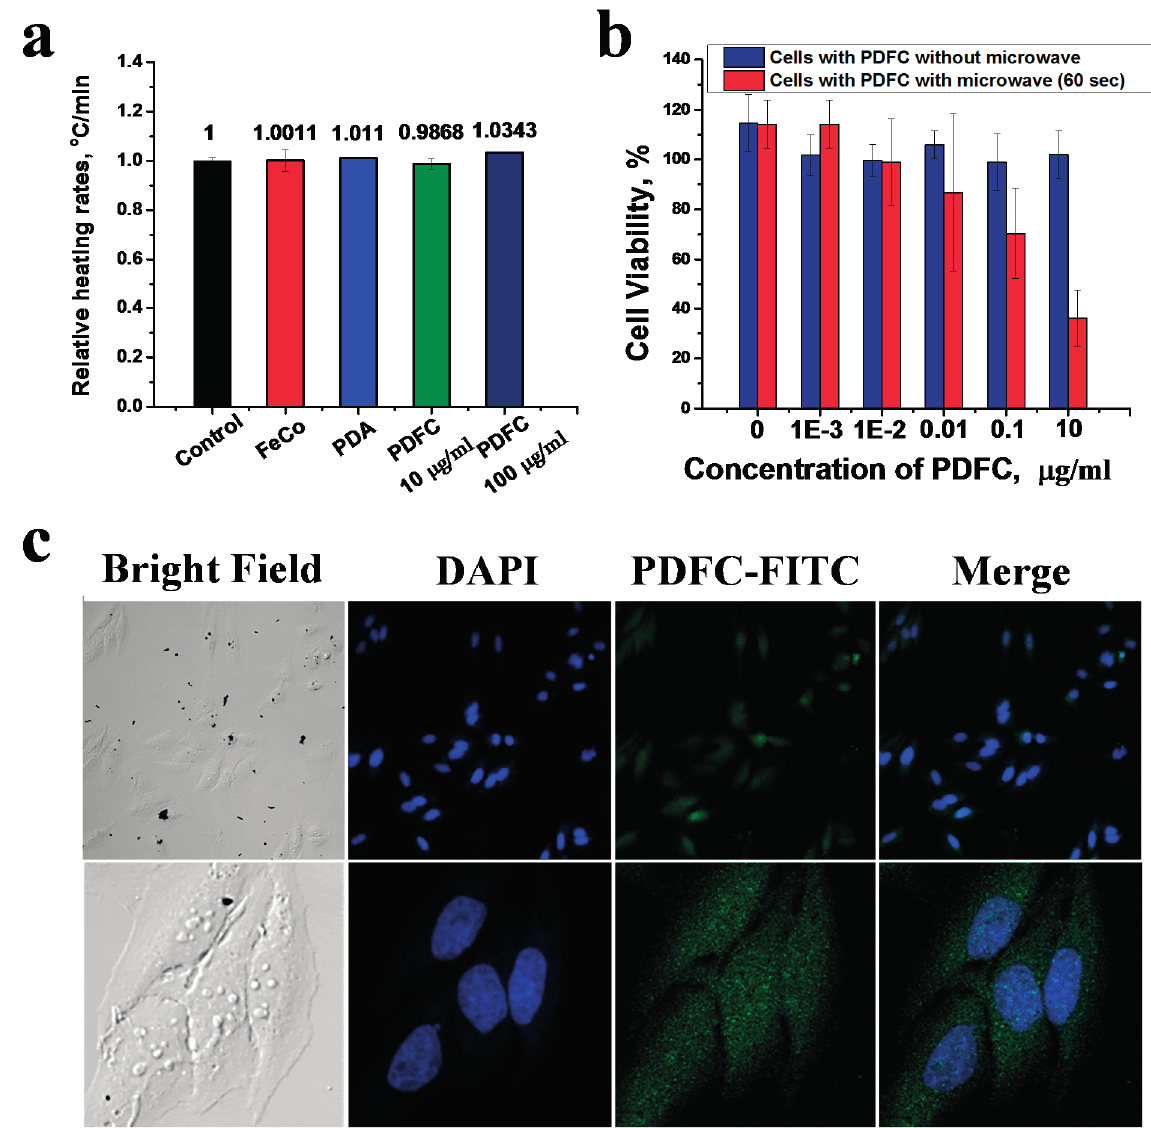
(Figure S1B) so the nanocubes could be tracked by their green fluorescence. CLSM images showed efficient uptake of most of the PDFC-FITC nanoparticles in 6 h (Figure 2c). Uptake was quantified by inductively coupled plasma optical emission spectrometry (ICP-OES) measurements (Figure S8) of Co and Fe concentrations after the 6 h of incubation with HeLa cells, using of initial dispersions of PDFCs in cell culture medium as controls The uptake was 45.7% for 100 µg/mL, 48.6% for 10 µg/mL and 41.8% for 1 µg/mL based on Fe. Based on Co it was 44.9% for 100 µg/mL, 46% for 10 µg/mL and 35.4% for 1 µg/mL.